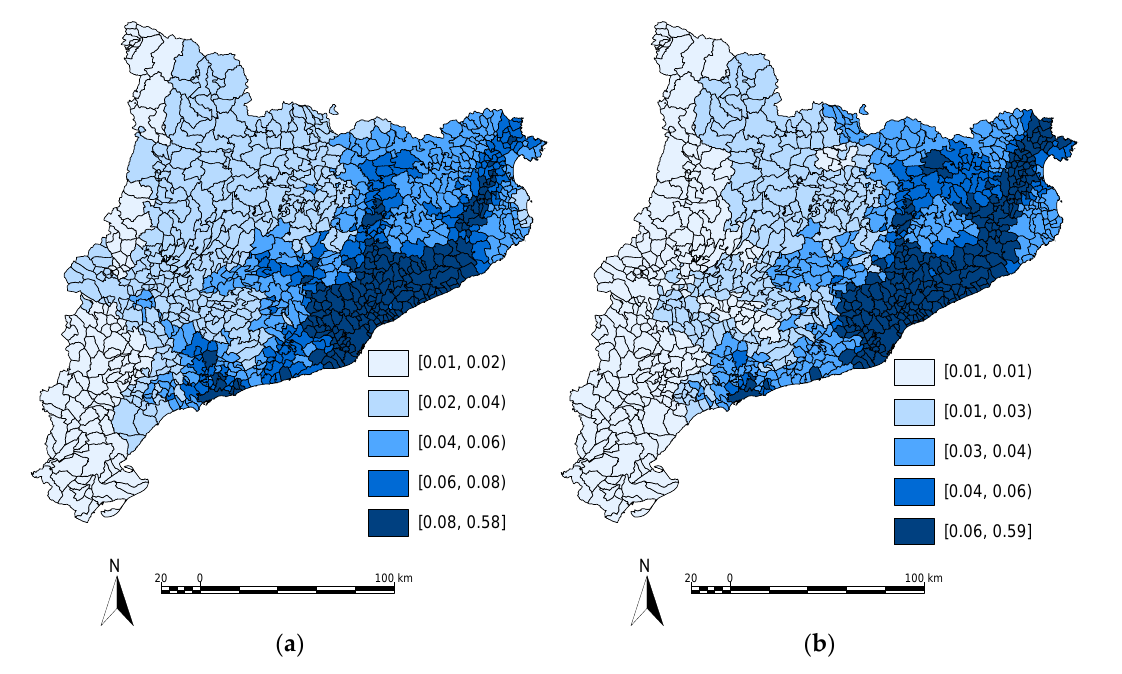
Figure 4. The Apparent Location Suitability Index (ALSI). Notes and sources: See Figure 3 and text. ( a ) Unweighted ALSI. ( b ) Weighted ALSI.